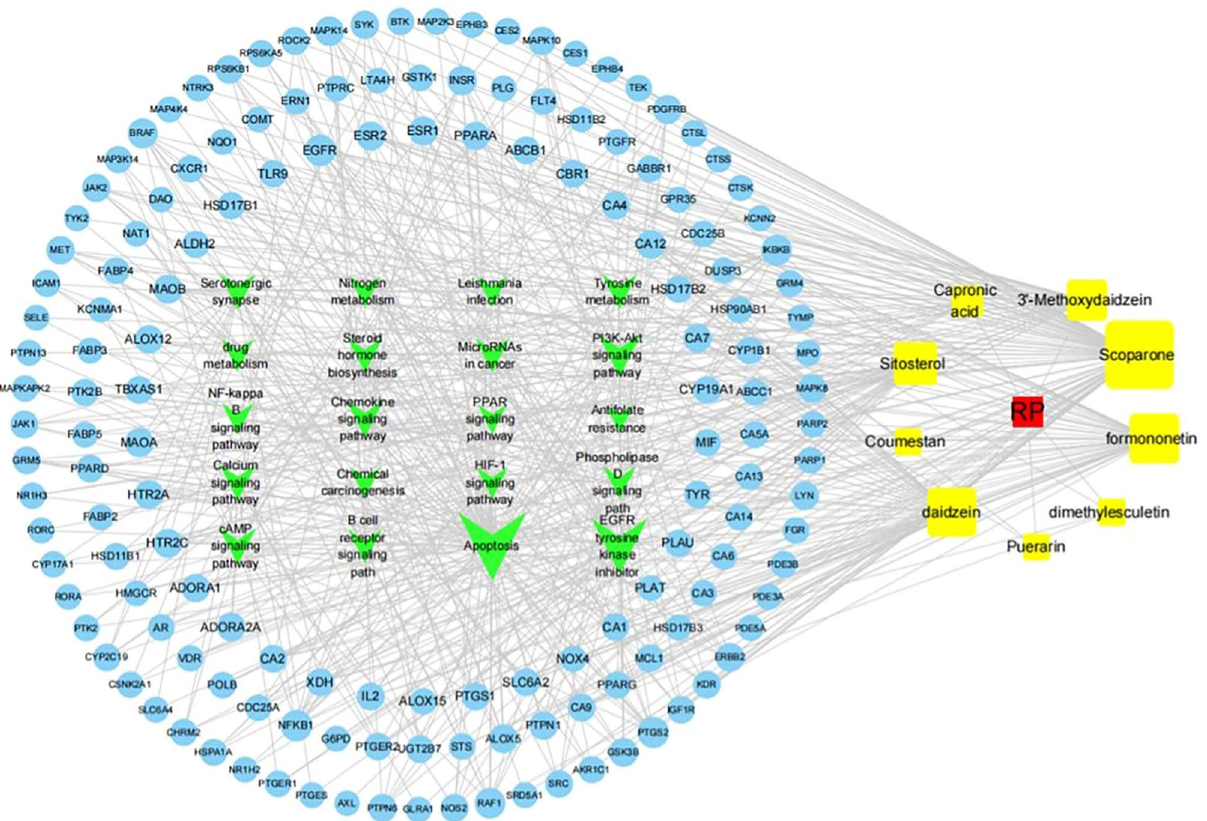
Figure 6. RP component-target-pathway network analysis. The red node refers to the drug; the green node represents pathways; the blue nodes represent targets; and the yellow nodes indicate components. The edges indicate their interactions.